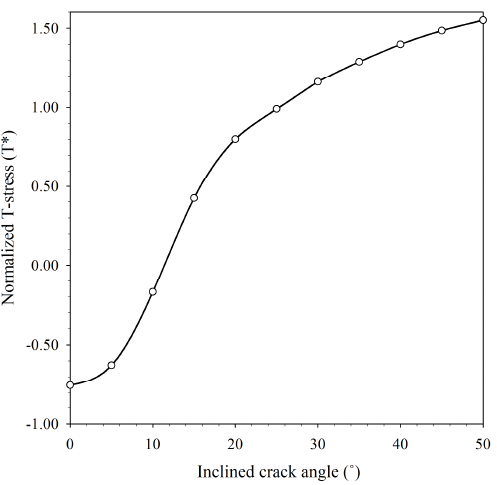
∗ ) of ICB specimen at a various inclined crack Figure 4. Normalized T-stress ( * T ) of ICB specimen at a various inclined crack angles. Figure 4. Normalized T-stress ( T